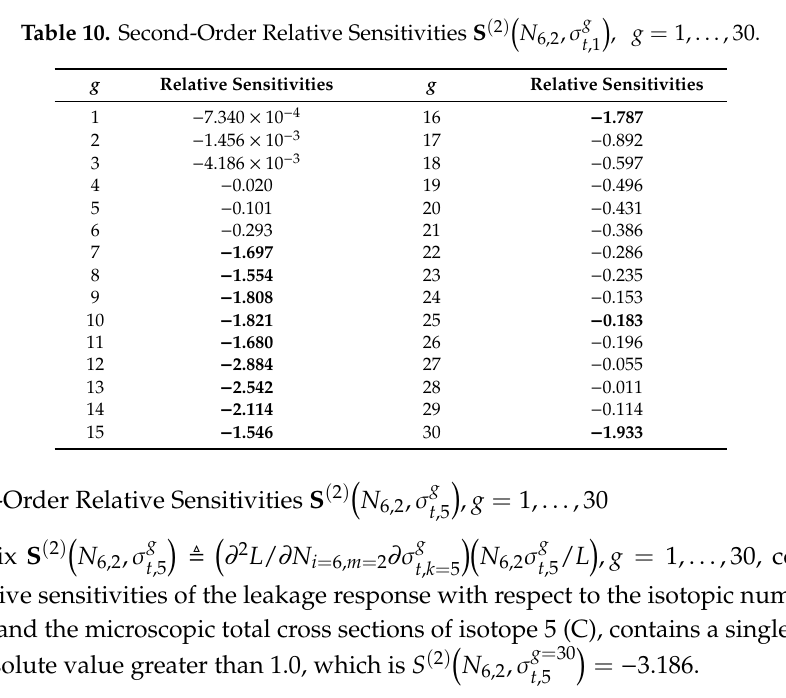
Table 11. Second-Order Relative Sensitivities S ( 2 ) g Relative Sensitivities g Relative